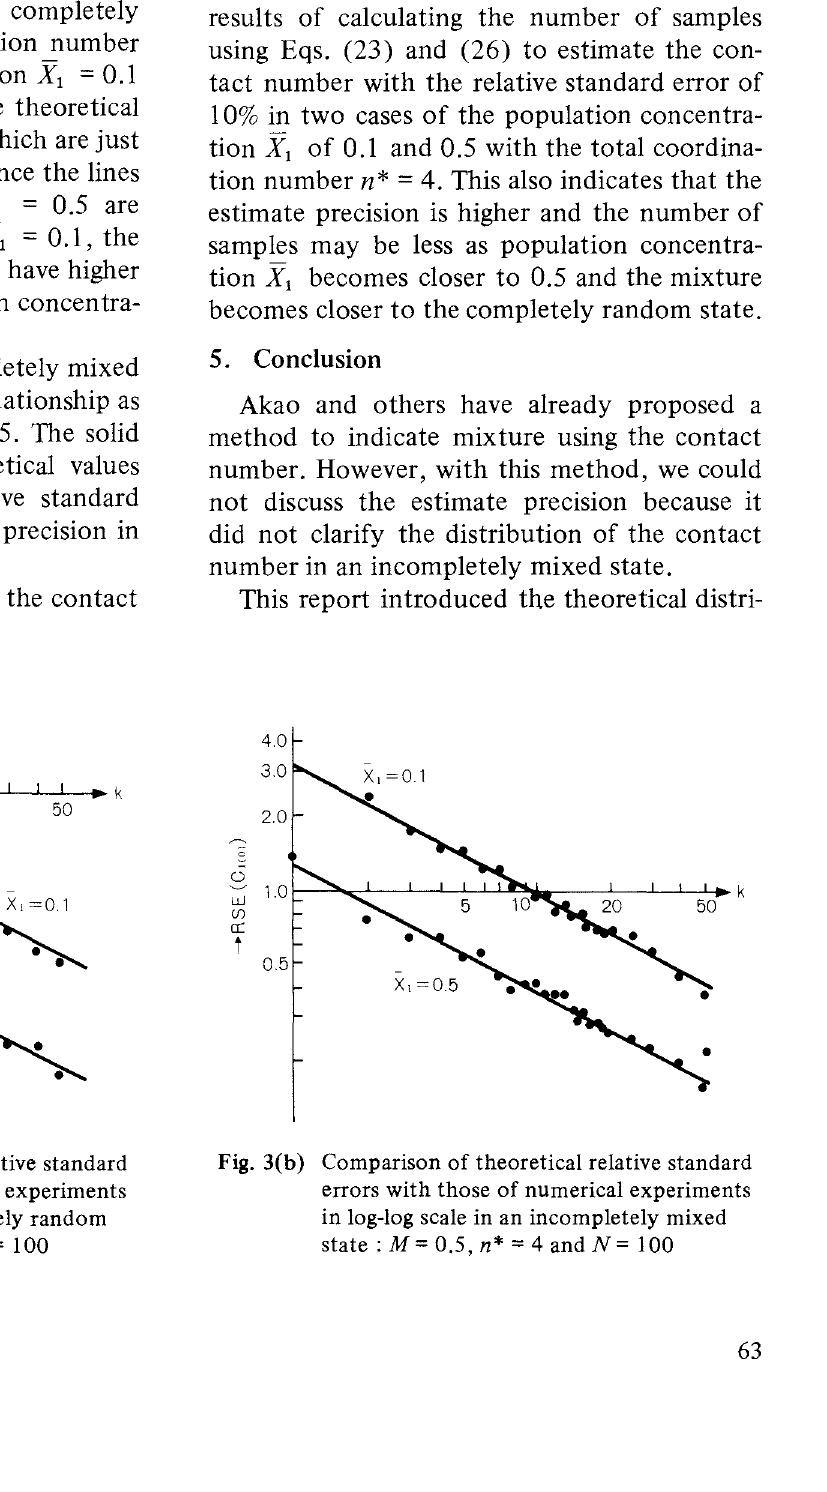
Fig. 3(b) Comparison of theoretical relative standard errors with those of numerical experiments in log-log scale in an incompletely mixed state: M= 0.5, n* = 4 and N=